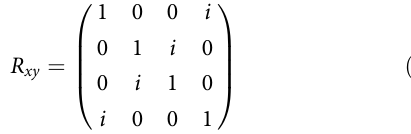
Projections in polarization space are made using a polarization